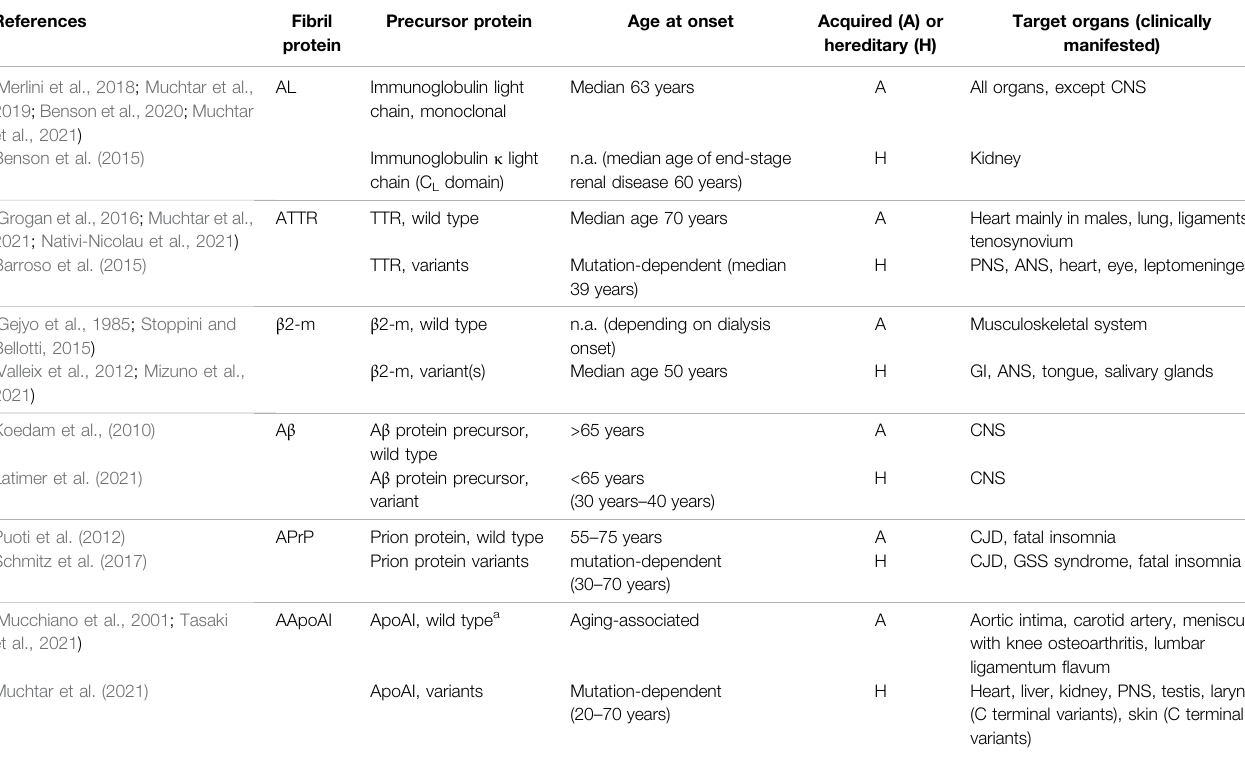
TABLE 1 | Proteins that can cause amyloid deposits in humans either in their wild type form or in presence of mutations.